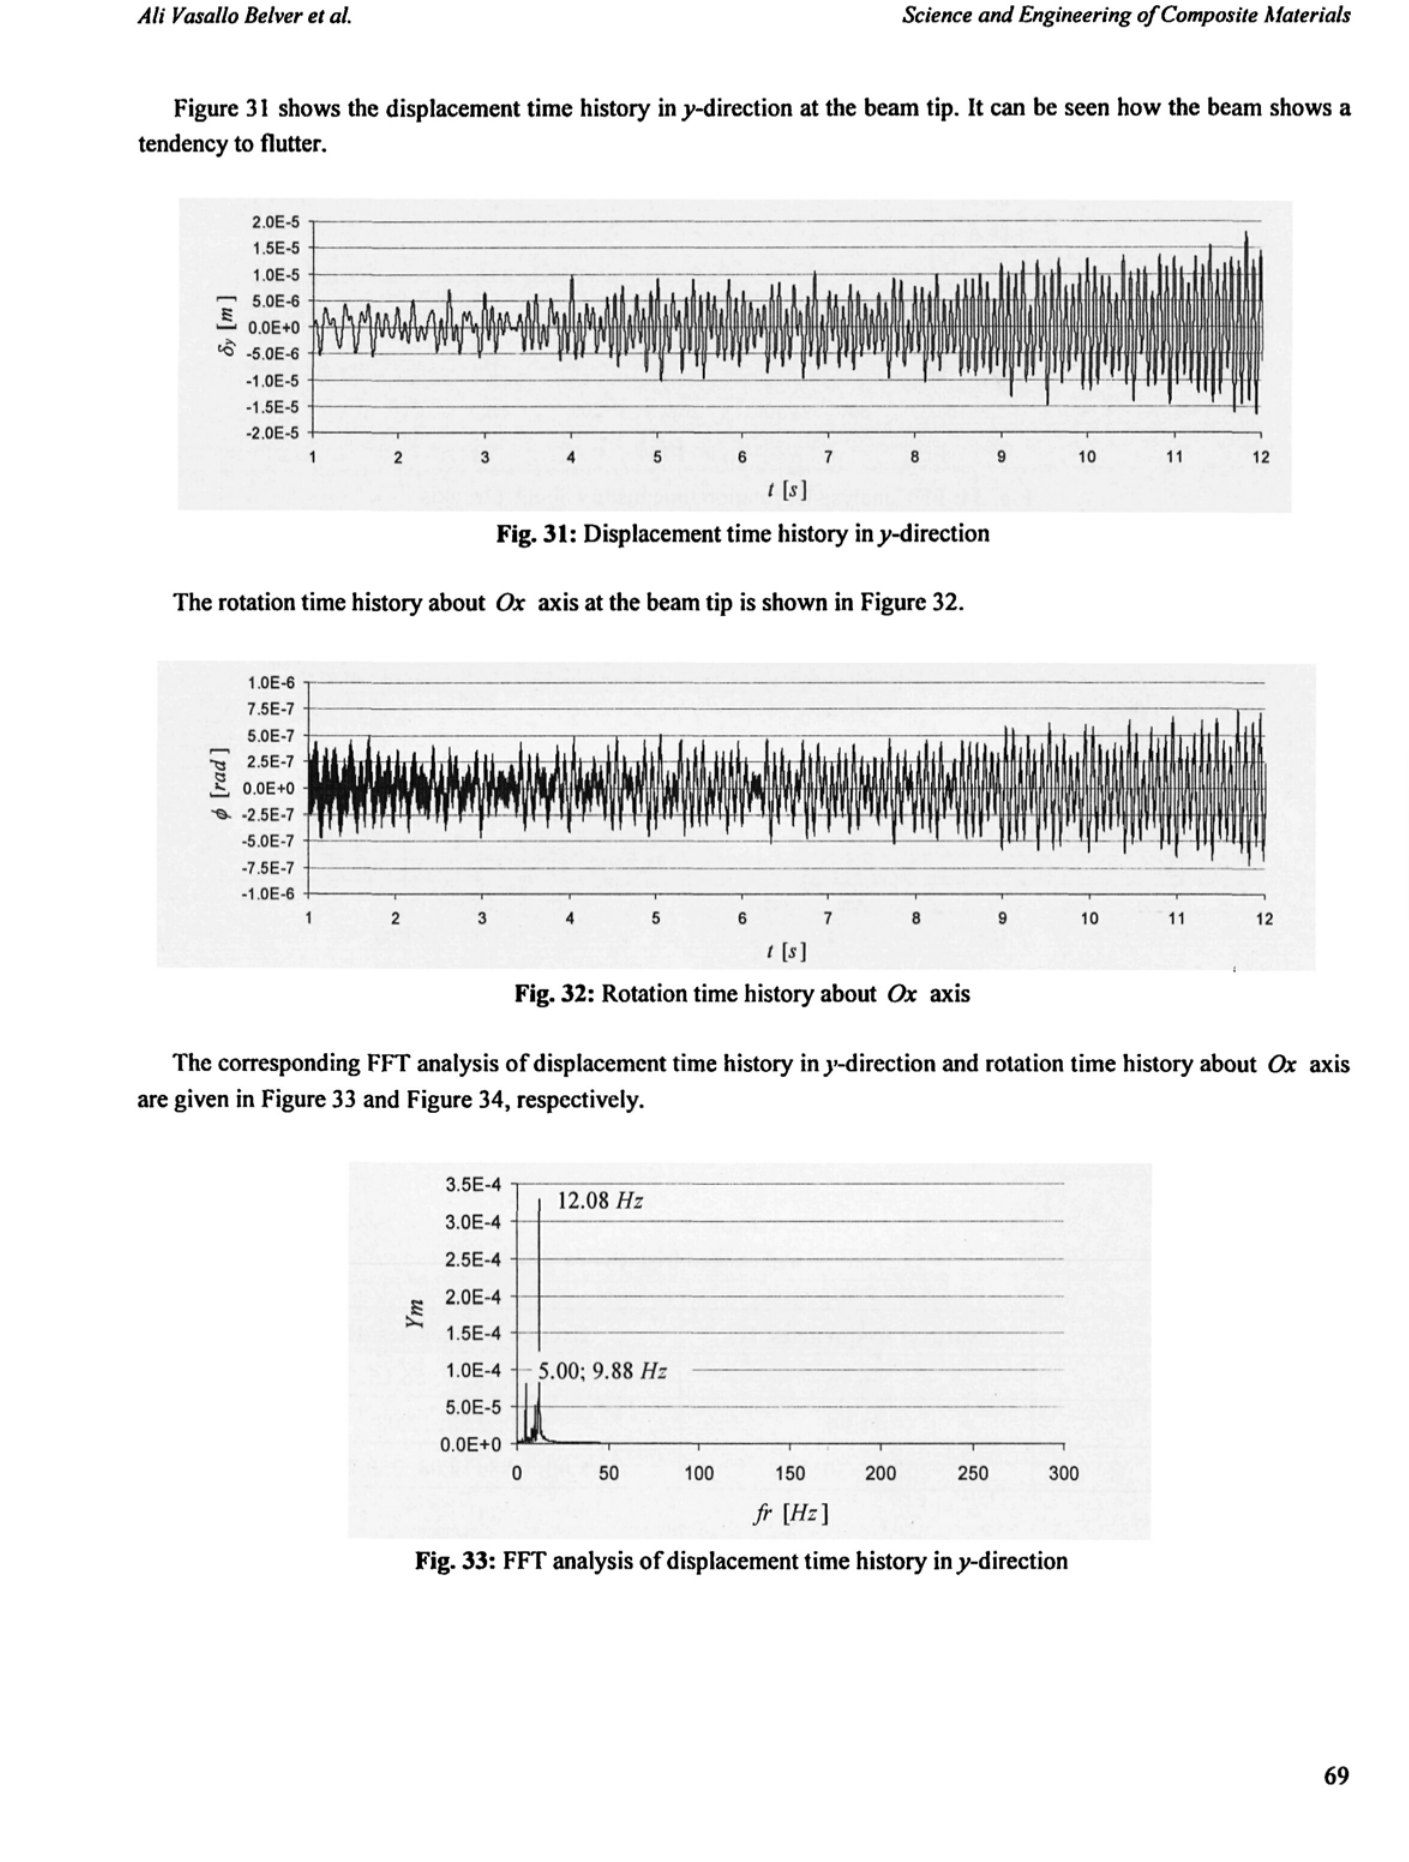
Fig. 31: Displacement time history in ^-direction